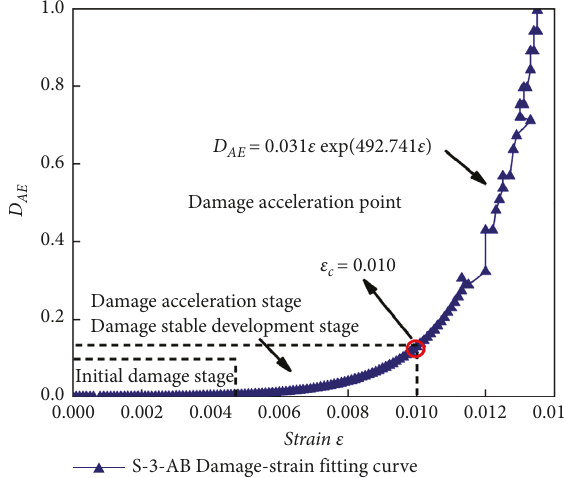
Figure 14: Damage-strain curve of